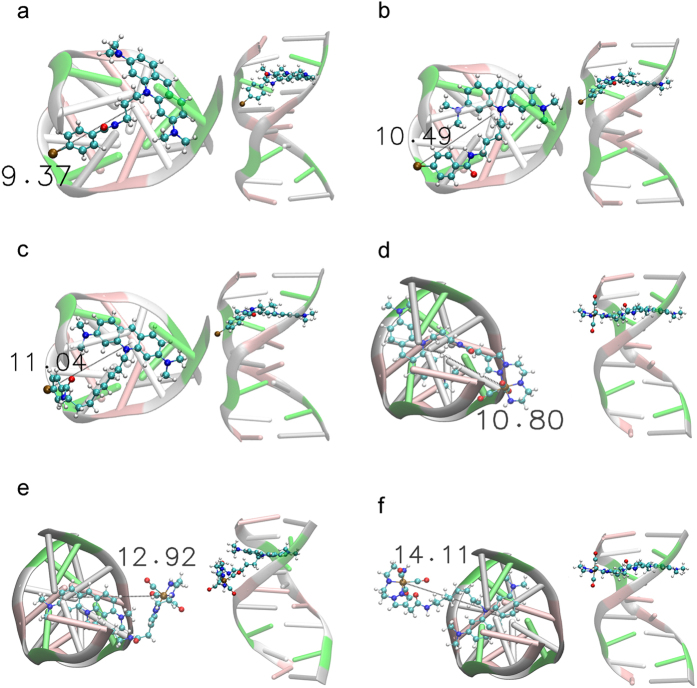
Top view and all structure view of the molecular docking top-ranked poses of the AO derivatives intercalated in the d(ACGTACGT)2 sequence.(a) 125I-C3; (b) 125I-C5; (c) 125I-C8; (d) 99mTc-C3; (e) 99mTc-C5 and (f) 99mTc-C8. Distance between the 125I or 99mTc atom relative to the DNA helical axis is displayed in Å.